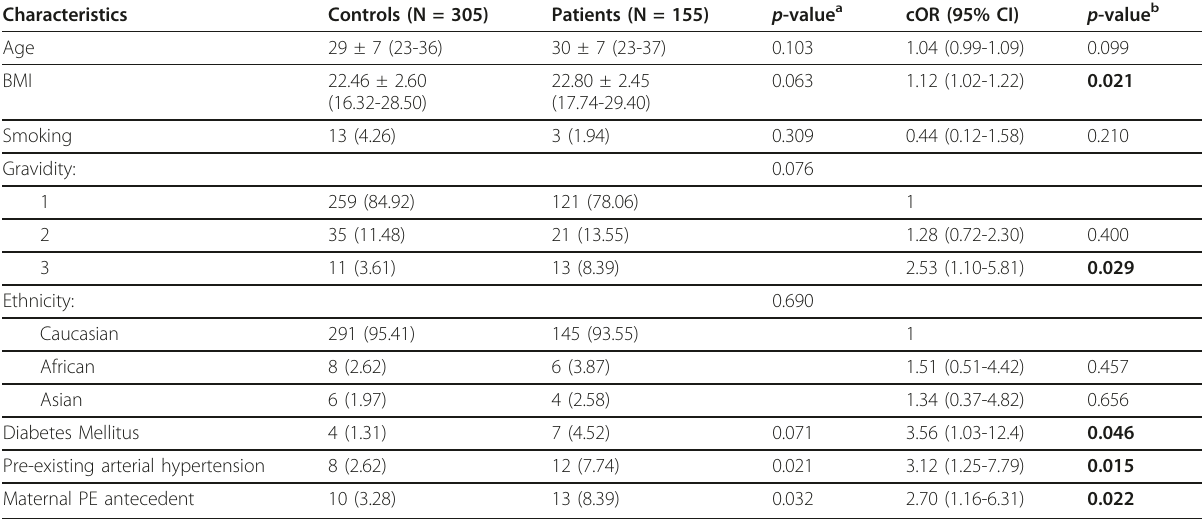
Table 2 Clinical characteristics of controls and patients